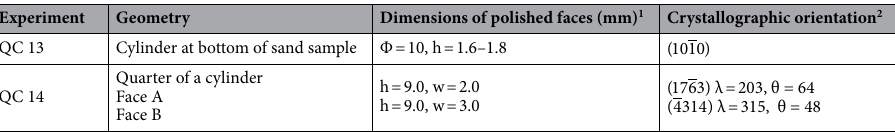
Table 1. Geometry of experiment and dimensions and orientation of polished faces on single crystals of quartz. 1 φ = diameter, h = height, w = width. 2 λ = azimuth, θ = dip, λ = 0º: crystallographic [1010] direction, θ = 0º: crystallographic [0001]